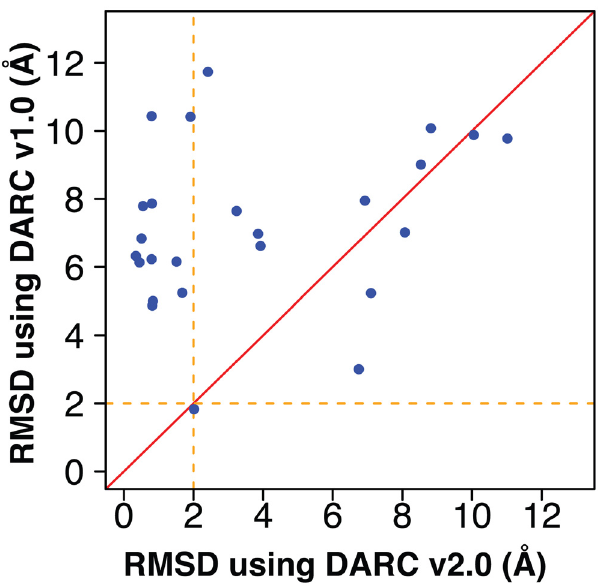
Fig 7. Summary of the collective effect of enhancements to DARC described here. For each protein- ligand complex in our set (S1 Table), we used DARC to dock the ligand back into its cognate receptor. Here we compare performance of DARC before the enhancements described in this work ( “ DARC 1.0 ” ), to its current performance ( “ DARC 2.0 ” ). Each point represents a separate complex; points above the diagonal are those for which the use of multiple origins led to better pose recapitulation. Previously, only one ligand (of 25) was docked to within 2 Å RMSD of its position in the crystal structure; in contrast, “ DARC 2.0 ” now achieves this level of accuracy in 12